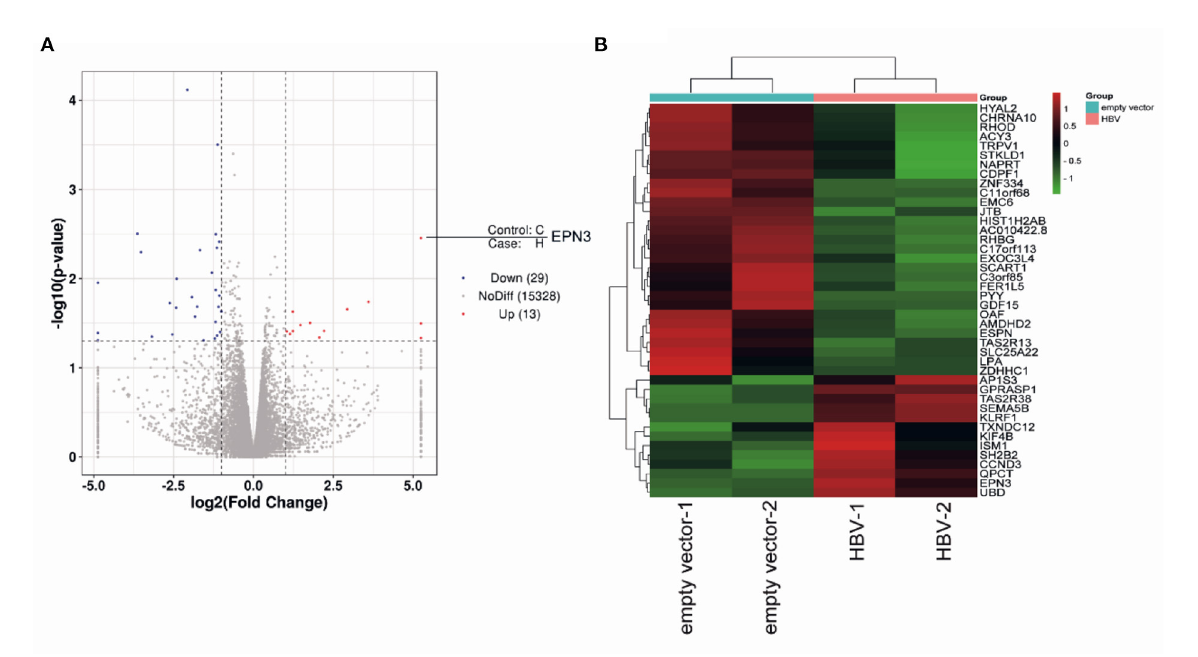
FIGURE1 RNA-seq of pPB-transfected Huh7 cells. Huh7 cells were transfected with an HBV-replicon plasmid (pPB), or the empty vector. Three days after transfection, cells were harvested for RNA sequencing. The differentially expressed genes are indicated as a volcano plot (A) and a heatmap (B)